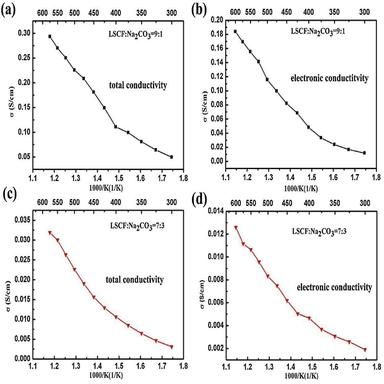
(a) the total conductivity and (b) electronic conductivity as function of temperature for LSCF/Na2CO3 composite powders with 10 wt% carbonate content.